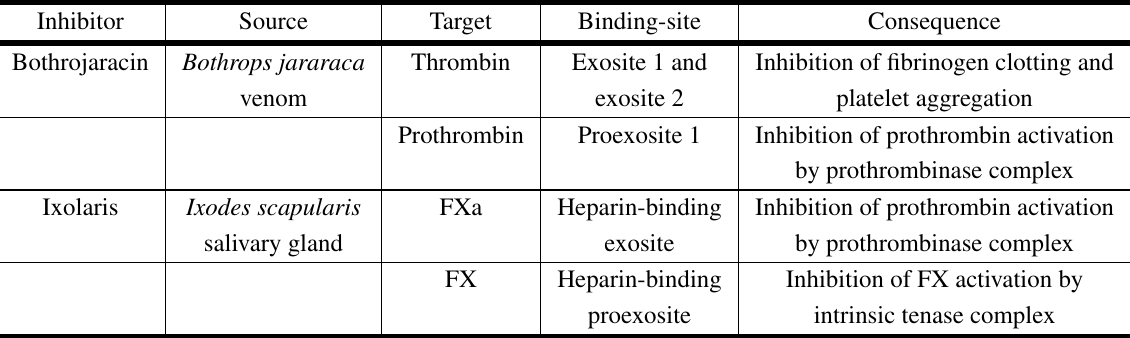
Two examples of exosite